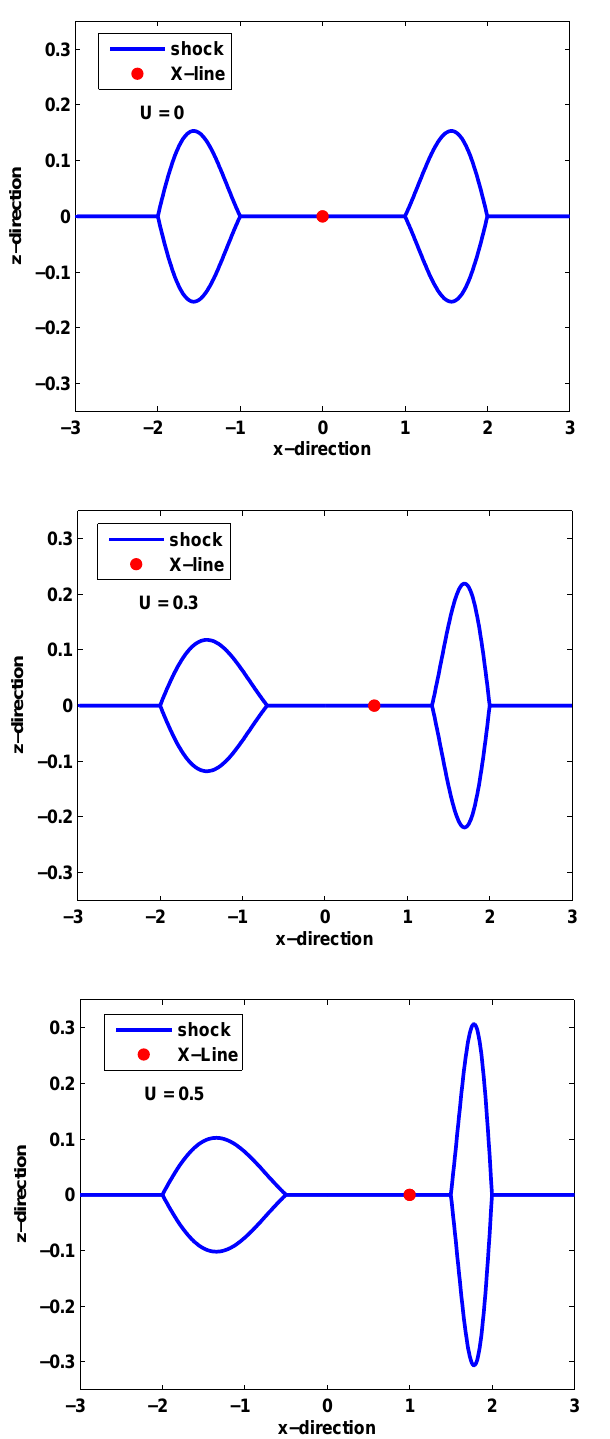
Fig. 5. Shape of the shocks. The upper panel shows the shape of the shock structures for the case U = 0 and t = 2 , the middle for U = 0 : 3 v A and t = 2 and the lower panel for the case U = 0 : 5 v A and t = 2 . The dot represents the final position of the reconnection line.